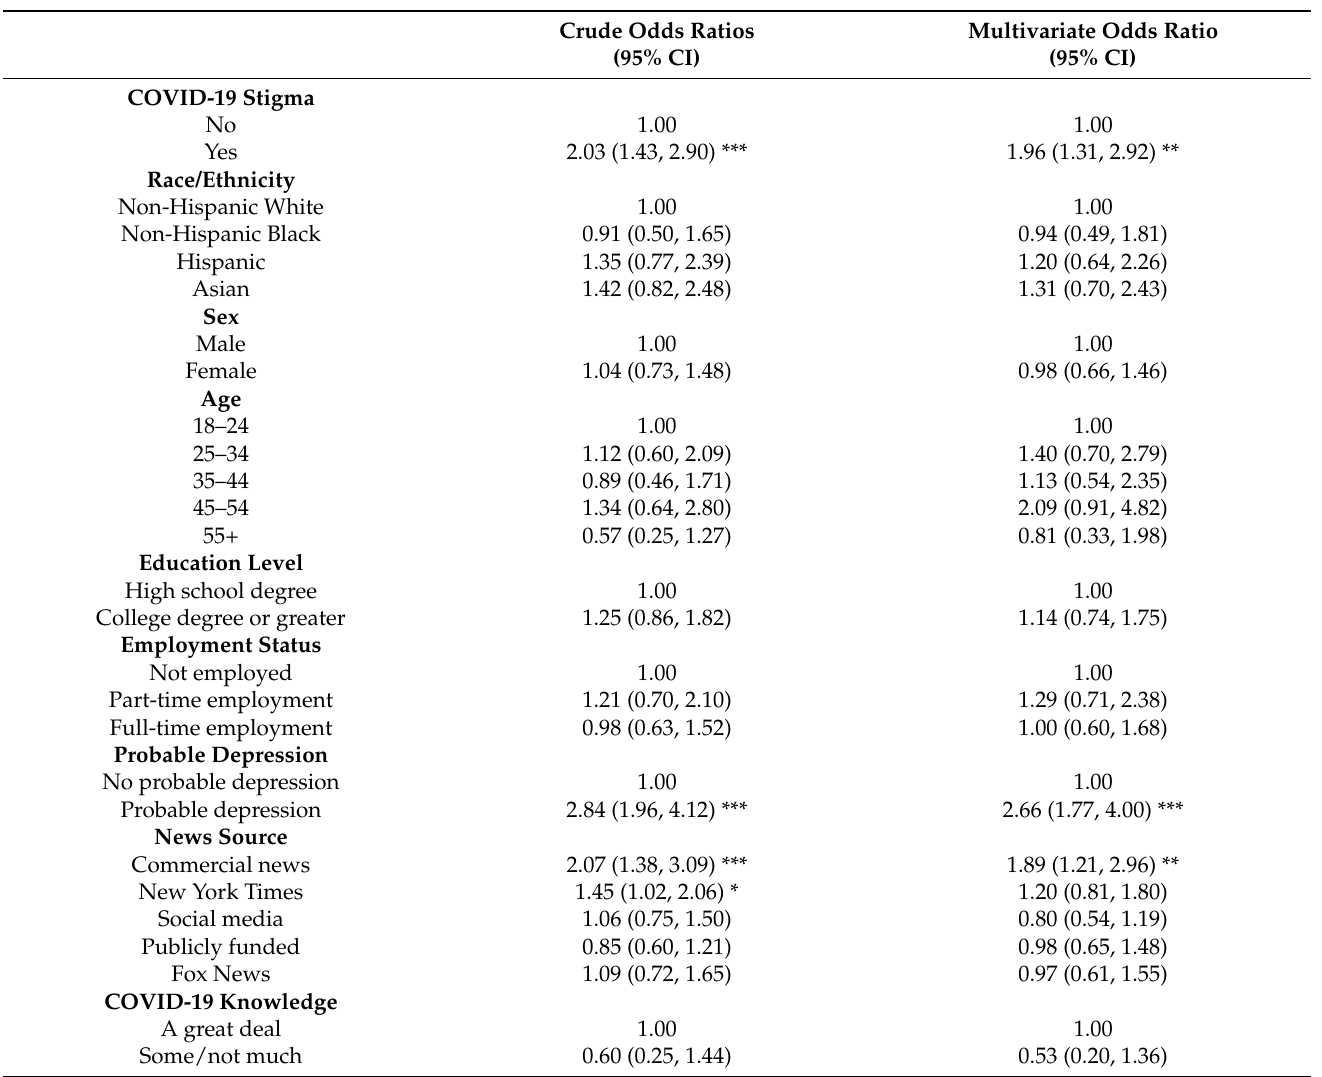
Table 3. Logistic regression predicting being very COVID-19 worried, New York State, N = 535.